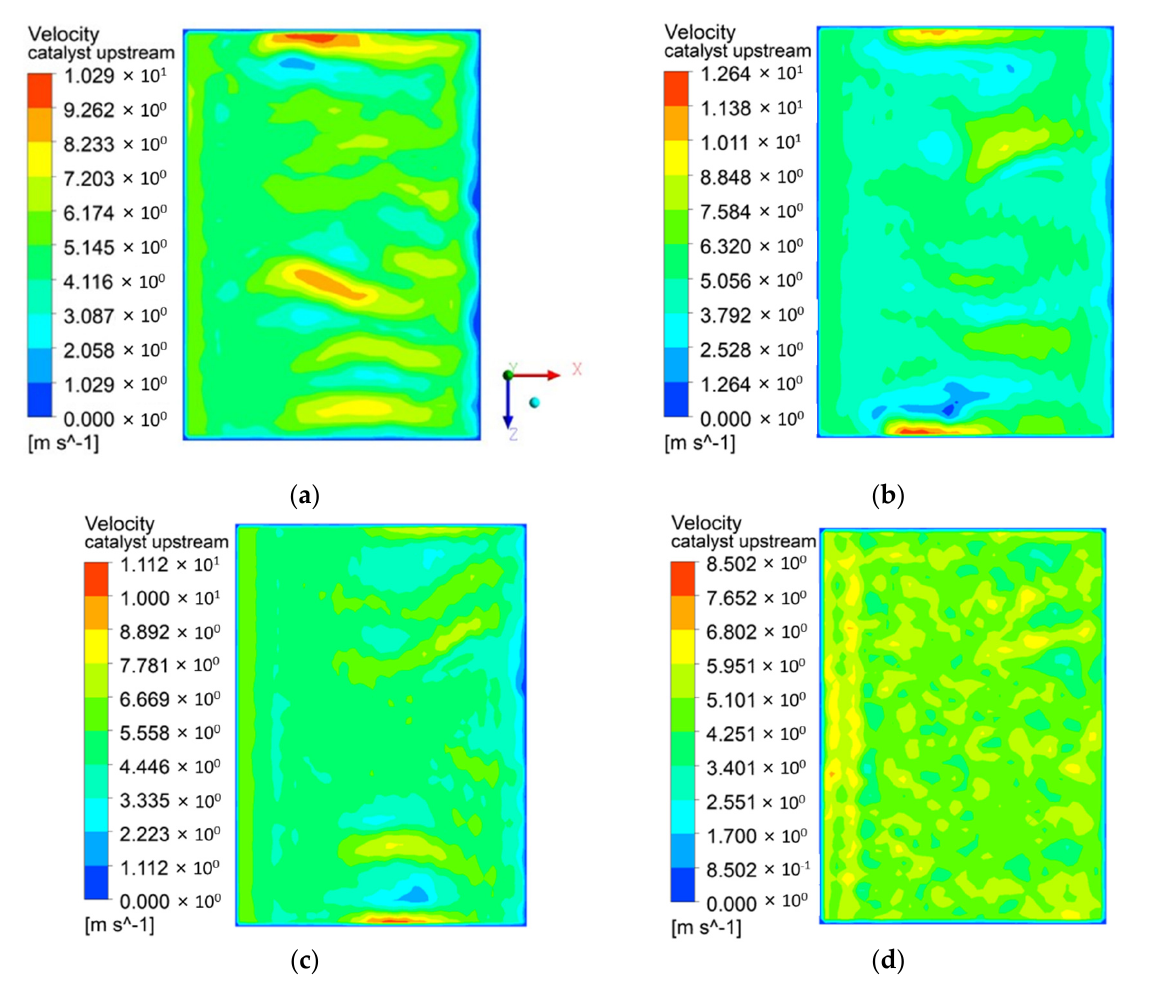
Figure 6. Contours of the velocity field distribution for the upstream cross − section of the catalyst inlet for the different schemes: ( a ) Scheme 1; ( b ) Scheme 2; ( c ) Scheme 3; ( d ) Scheme 4. Table 3. Summary of C V values of the velocity field distribution for the upstream cross − section of the catalyst inlet corresponding to different schemes.